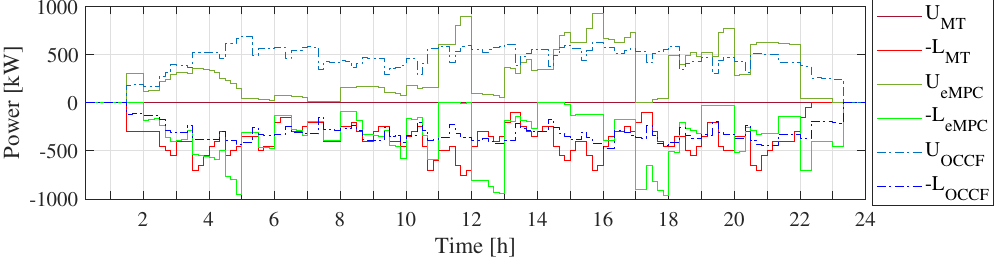
Figure 9. EVCS flexibility